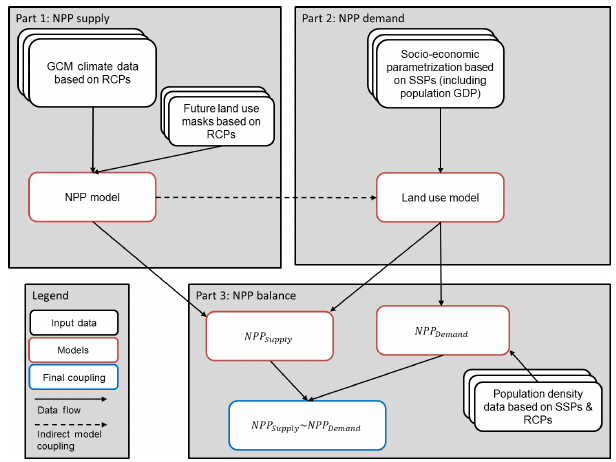
Figure 1. Conceptual logic of the modelling framework. The framework is based on three components enclosed by three grey boxes: (1) NPP supply , (2) NPP demand , and (3) NPP balance . The white boxes indicate data inputs originating from modelling stud- ies (as referenced in Sect. 2.2). The main models and equations are given in the boxes outlined in red, with solid arrows showing the data flow. The dashed arrow between the NPP model (Sect. 2.1.1) and the land use model (Sect. 2.1.2) represents an indirect model coupling for areas of cropland and pasture. The box outlined in blue indicates the final coupling allowing for the assessment of NPP supply and NPP demand .